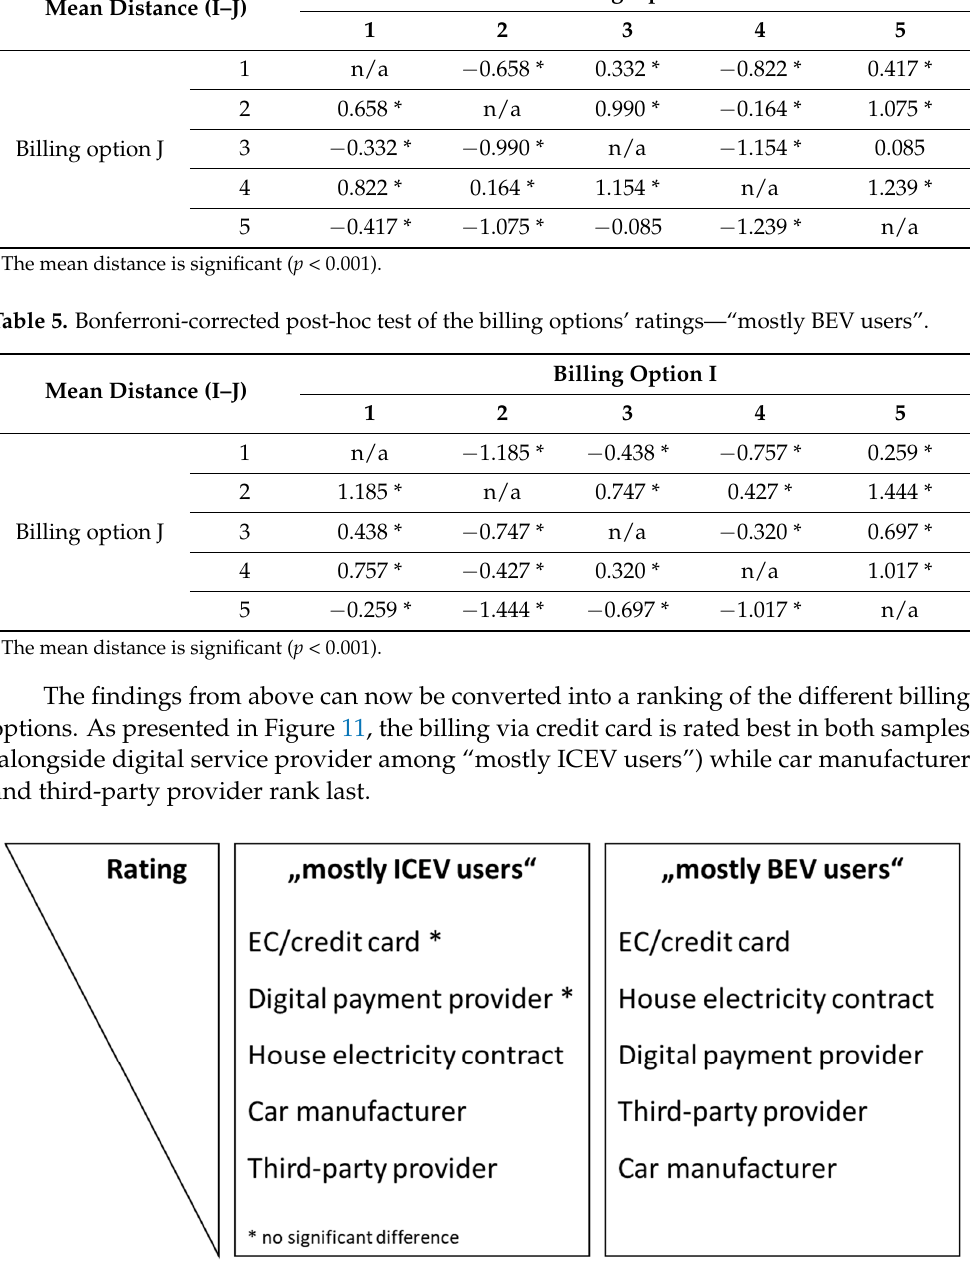
Figure 11. Ranking of different billing options (own figure).